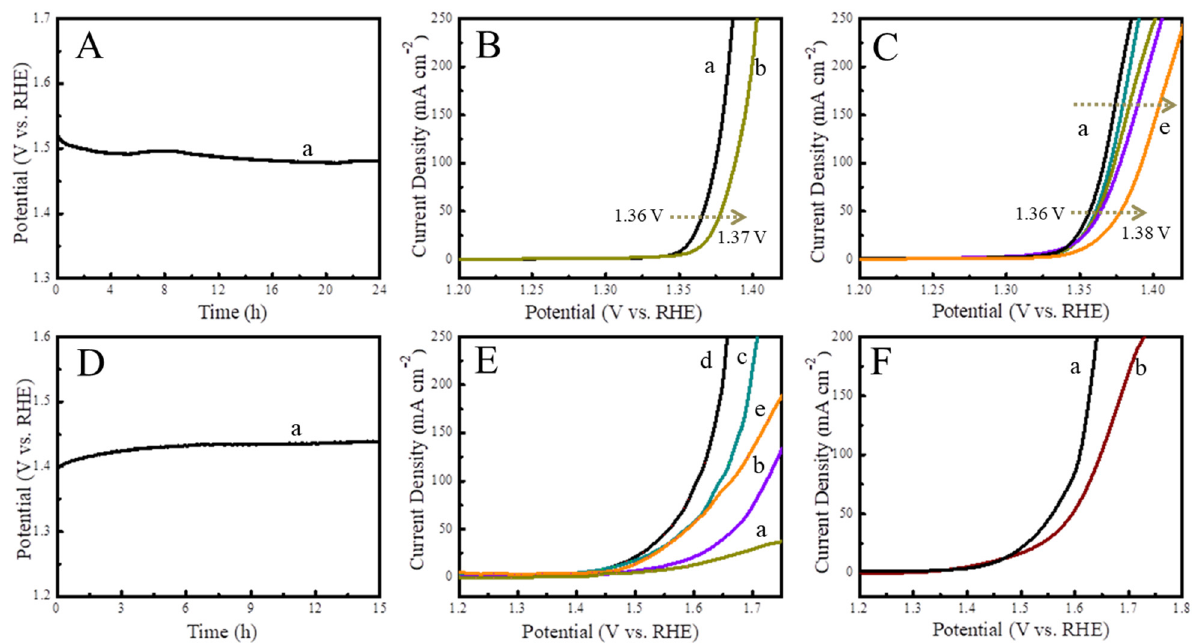
Figure 6. ( A ) Chronopotentiometry curve obtained for Ni 2 P@NiO/NiF-40 (curve a) catalyst elec-